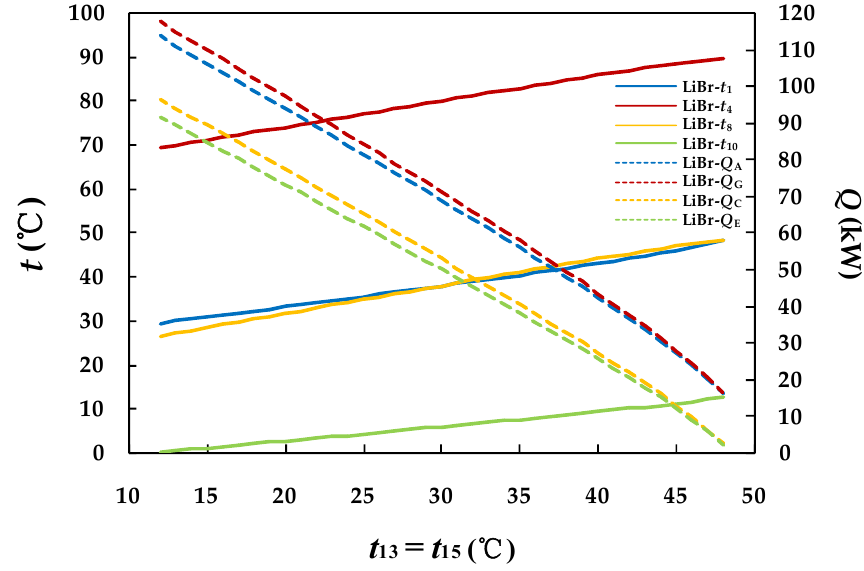
Figure 17. Variation of the exit temperature and heat capacity of each component with the cooling water inlet temperature for the LiBr-H 2 O absorption chiller.